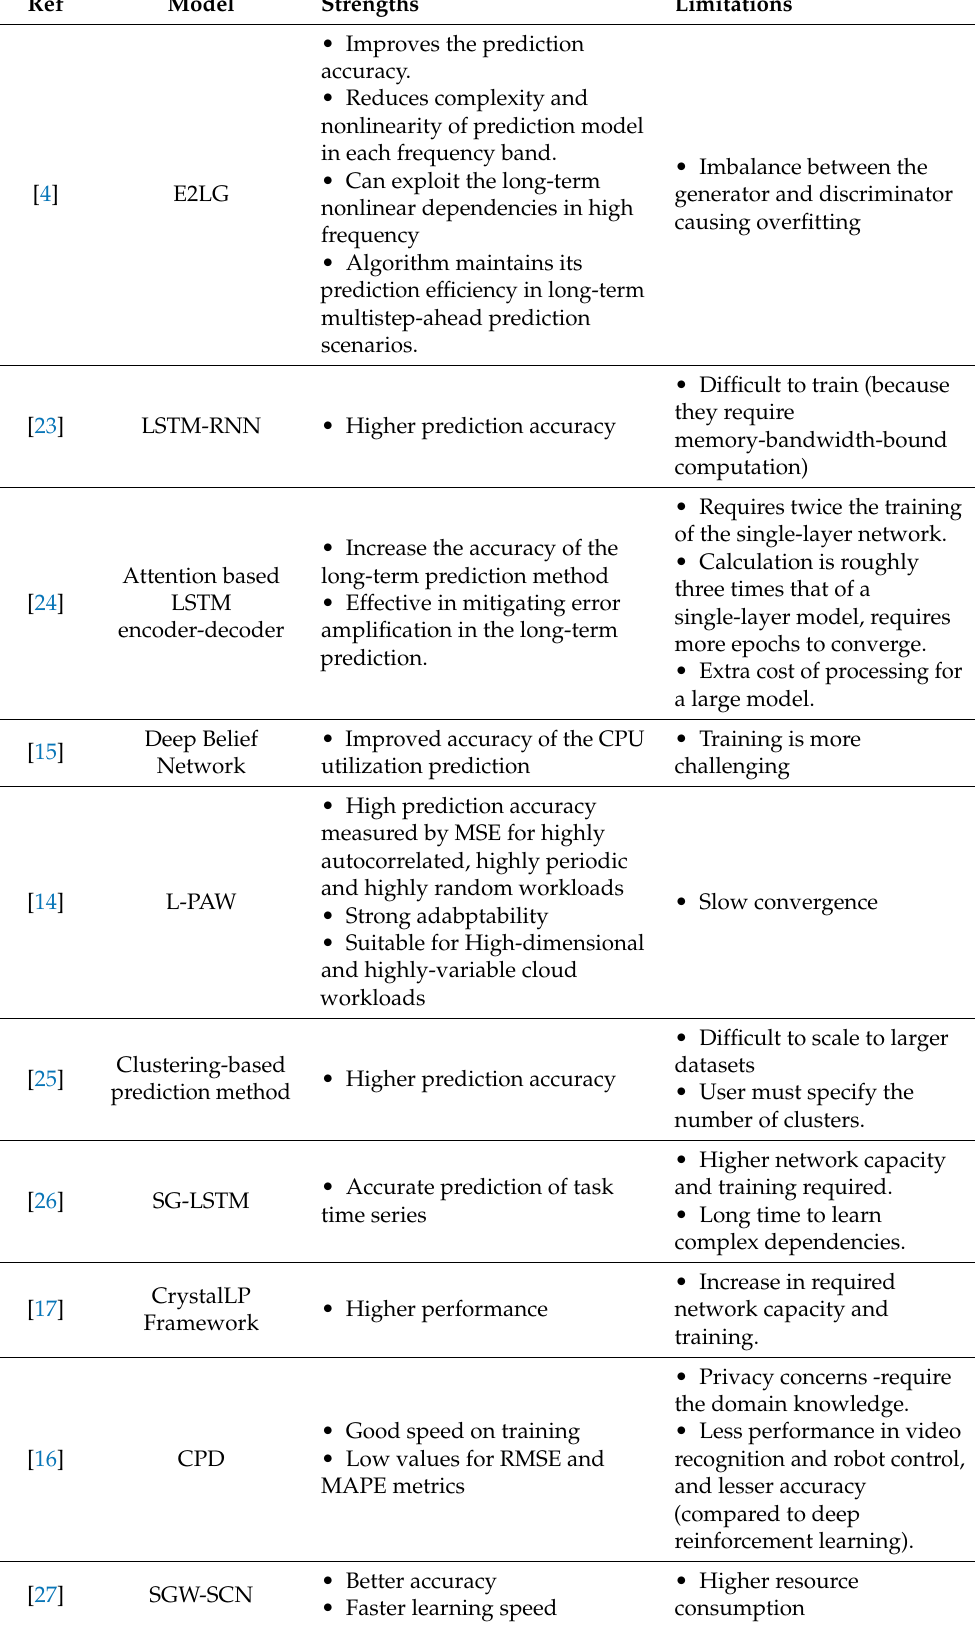
Table 1. Comparison of strengths and limitations of the DL